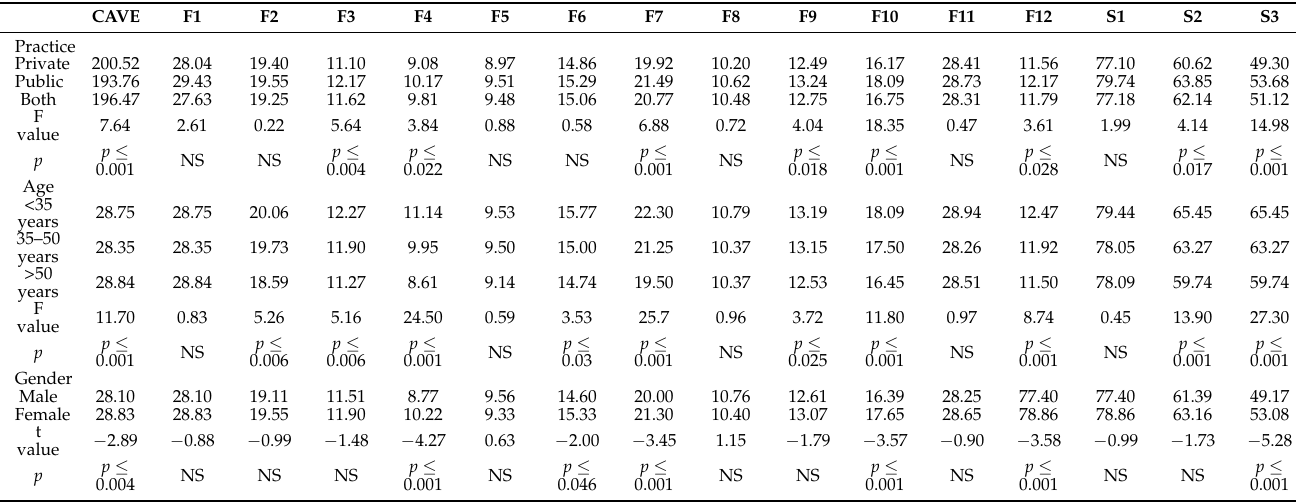
Table 7. Scores distribution according to sociodemographic